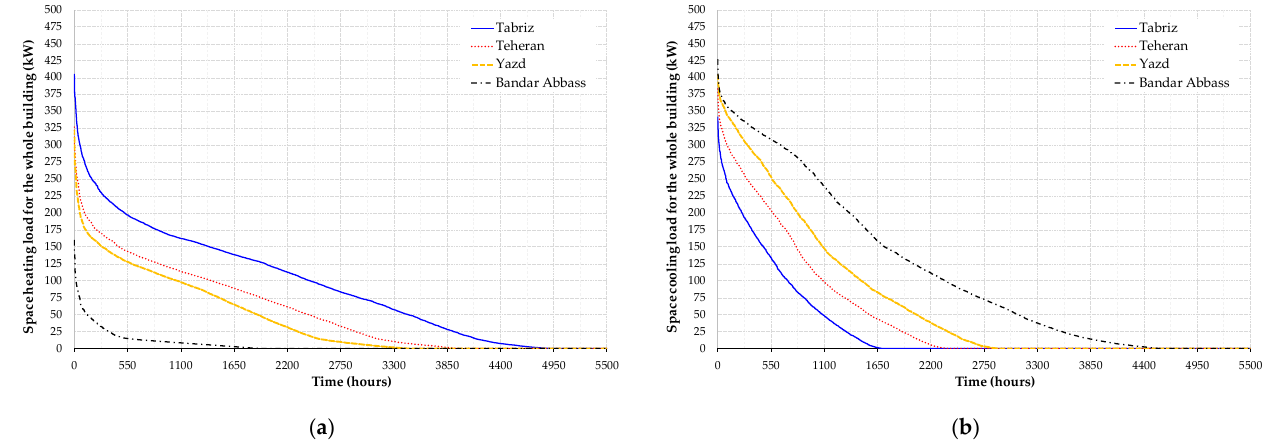
Figure 4. Space ( a ) heating and ( b ) cooling load-duration diagram associated with the whole building for the north-south orientation cases.